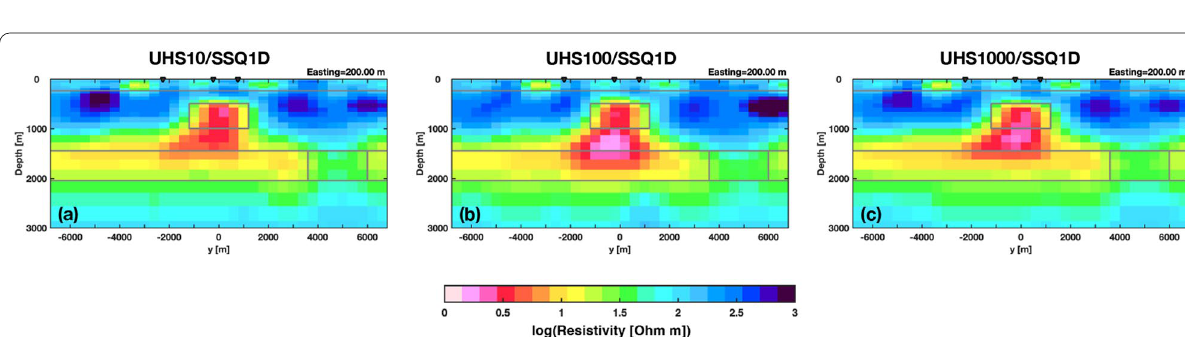
Fig. 29 NS cross sections at the easting of 200 m of the models inverted from the synthetic model (Fig. 1) with near‑surface distorters (Fig. 20). All used SSQ1D as a prior model, but the initial models, a UHS10, b UHS100, and c UHS1000, were examined